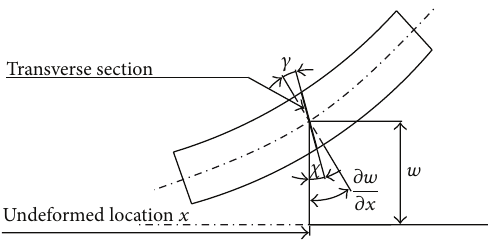
Figure 6: The Timoshenko beam kinematics.